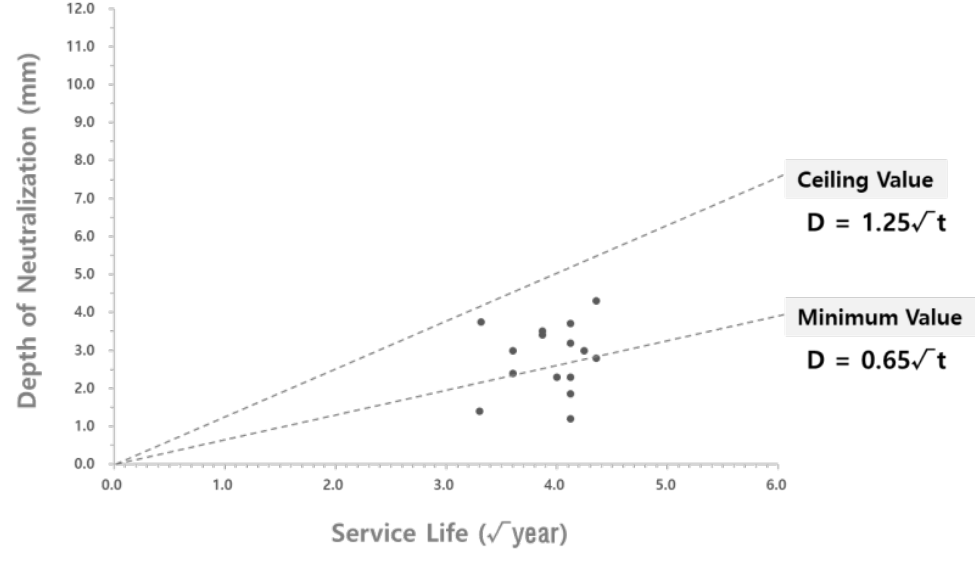
Figure 4. Carbonation depth distribution on the inner wall of the water reservoirs (waterproof- ing/anticorrosive method applied from the initial stage of service life) - according to the theoreti- cal equation.